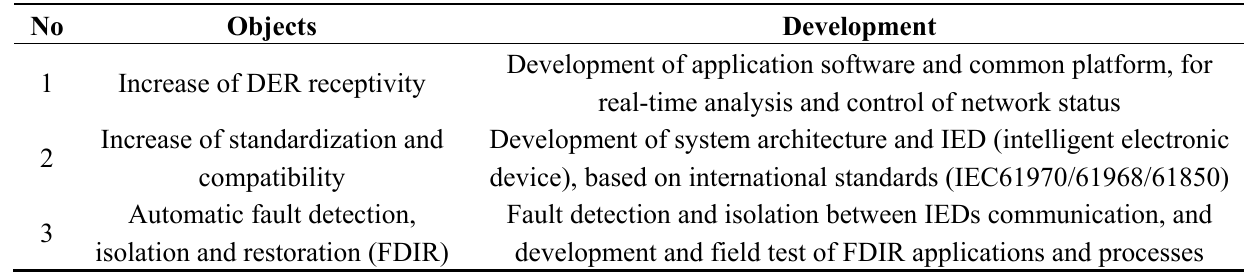
Table 2. Summary of Development for key objectives of